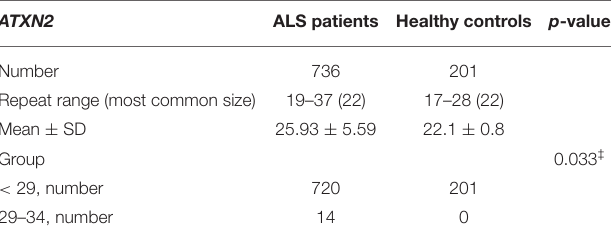
TABLE 3 | Analysis of intermediate-length CAG repeats in the ATXN2 gene in ALS patients and controls.